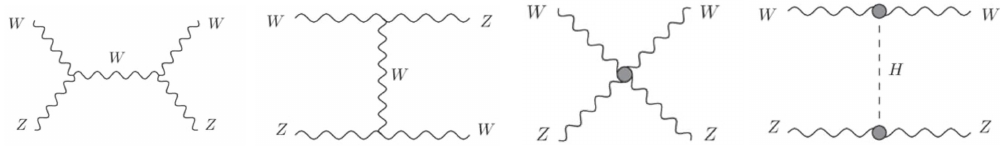
Figure 1 . The s and u channels and the contact term for the scattering W L Z L → W L Z L , in addition to the Higgs exchange diagram which unitarizes the former